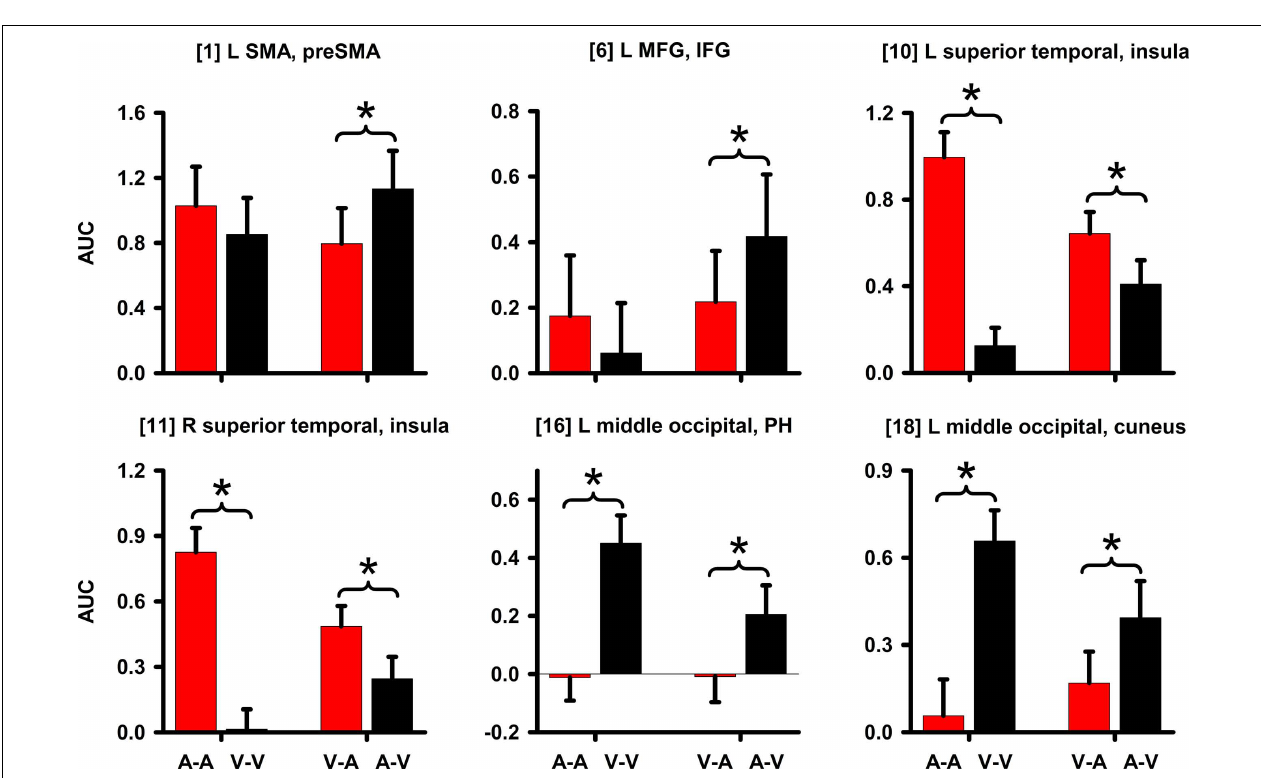
FIGURE 5 | Signal change in regions showing an effect of timing condition. Graphs display representative regions showing differences in activation between the unimodal (A–A,V–V) and crossmodal (V–A, A–V) conditions. Mean (standard error bars) area under the curve (AUC) is plotted